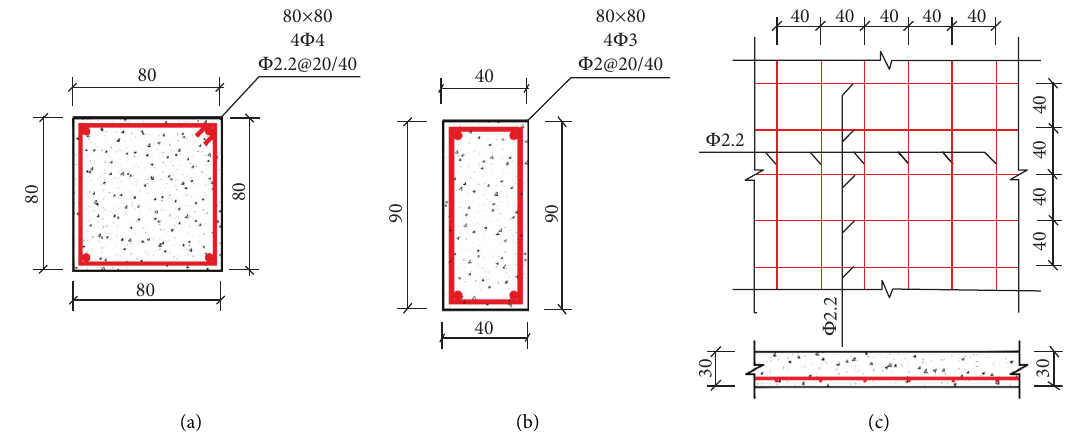
Figure 18: The reinforcement drawing of RC frame with infilled wall (unit: mm). (a) Frame column reinforcement drawing. (b) Frame beam reinforcement drawing. (c) Slab reinforcement